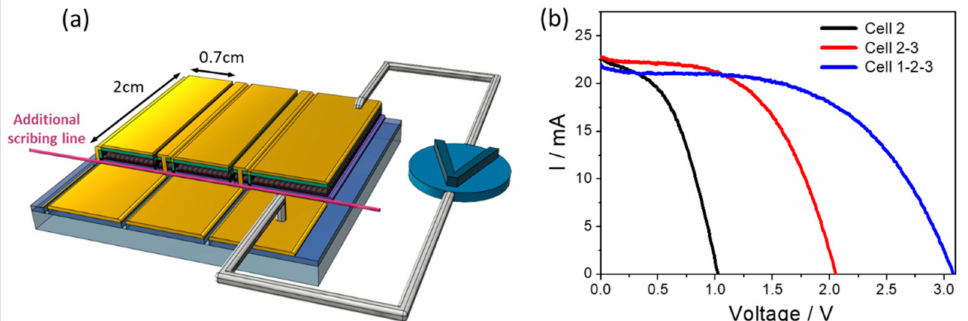
Figure 4. ( a ) Schematic diagram of the unique pattern for I–V measurement. ( b ) IV curves of single cell (Cell 2), two cells (Cell 2-3) and three cells (Cell 1-2-3) in series refer to the PbI 2 /DMF